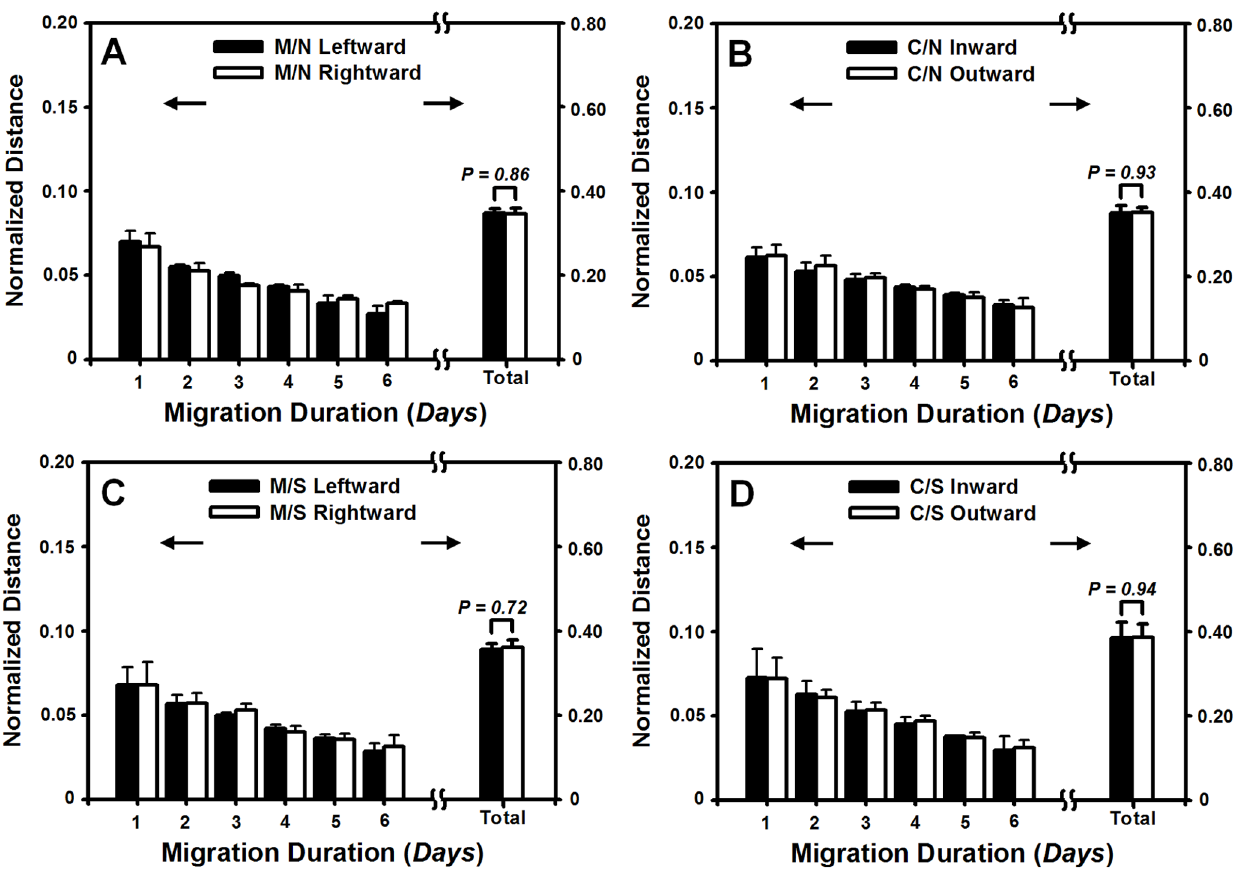
Figure 3. Lateral migration of HF cells on collagen I-coated PDMS membrane in the absence or presence of HaCaT cells and mechanical stretch. ( A, B ) Time course of normalized instantaneous or accumulative distance of monocultured (M/N) ( A ) or cocultured (C/N) ( B ) HF cells in the absence of mechanical stretch. ( C , D ) Time course of normalized instantaneous or accumulative distance of monocultured (M/S) ( C ) or cocultured (C/S) ( D ) HF cells in the presence of mechanical stretch. Data were collected and presented in the same way as Fig. 2.